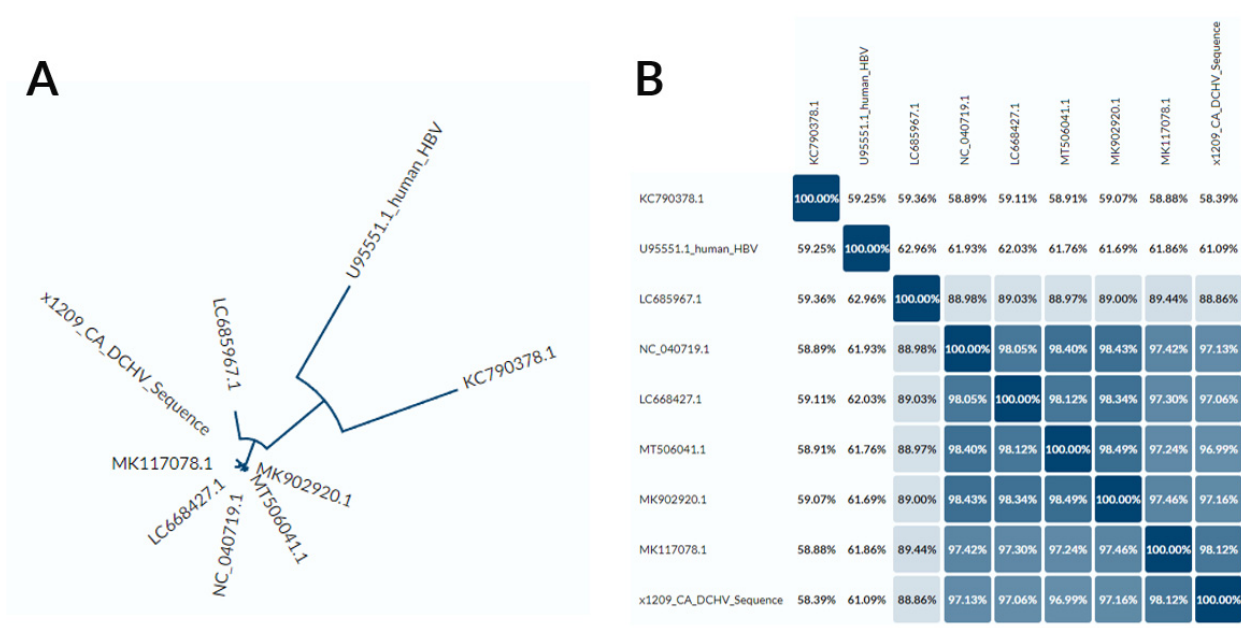
Figure 3. Phylogram ( A ) and identity matrix ( B ) based on whole DNA genome of DCH isolates, human HBV, and tent-making bat HBV. LC685967.1 = Japan isolate 1 (Rara); NC_040719.1 = Sydney isolate; LC668427.1 = Japan isolate 2; MT506041.1 = Thailand isolate; MK902920.1 = Malaysia isolate; MK117078.1 = Italy isolate. Alignment and figure generated using Uniprot Align [23].